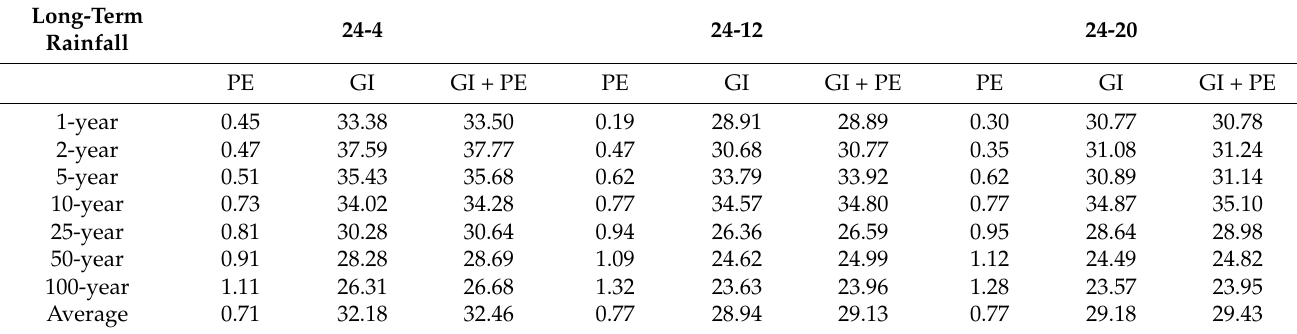
Table 3. Average reduction rate of road inundation in short-term events. Short-Term